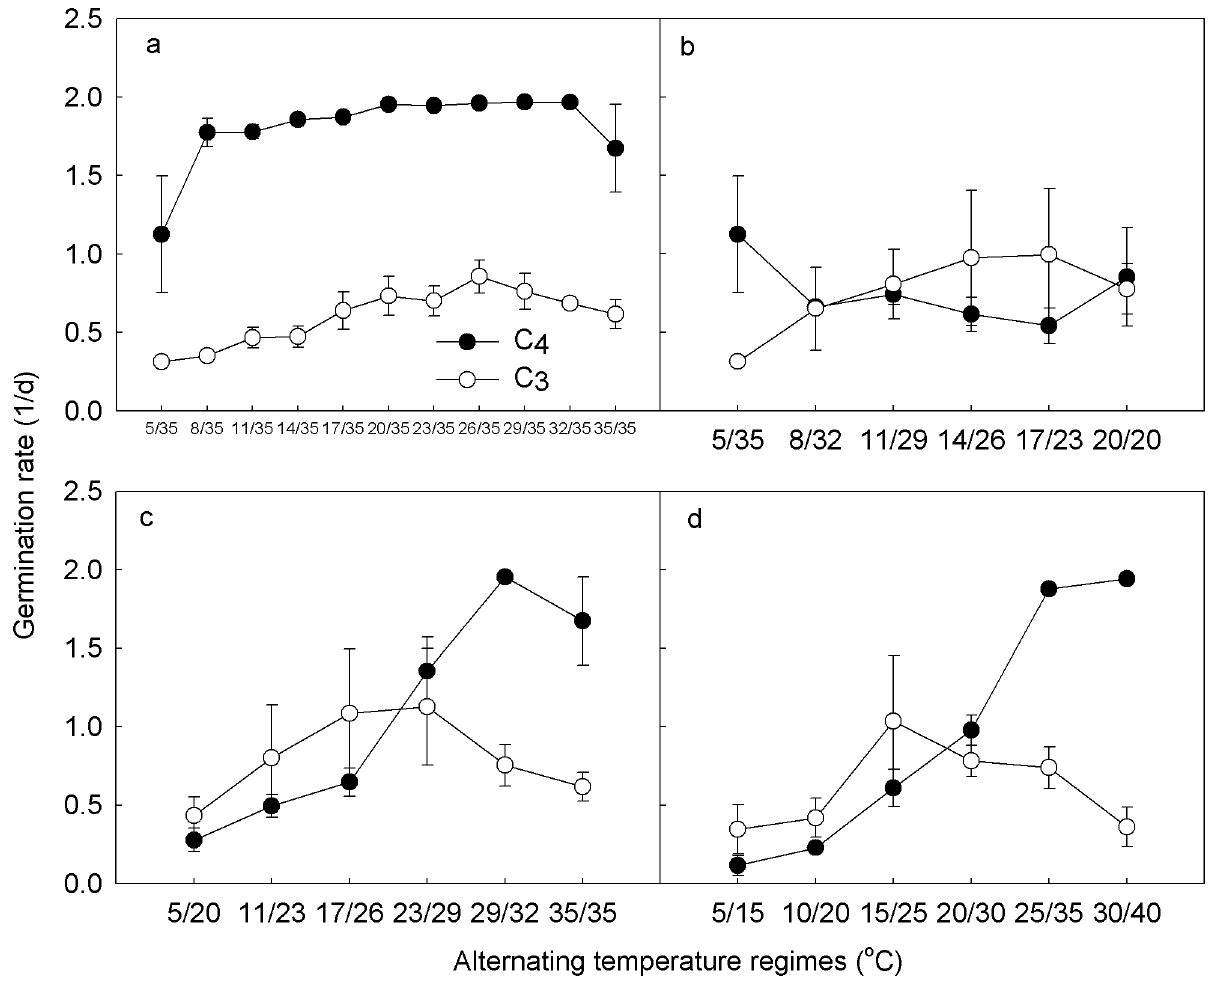
Figure 2. Germination rates of C 4 and C 3 species under different alternating temperature regimes. See Fig. 1 for symbols.